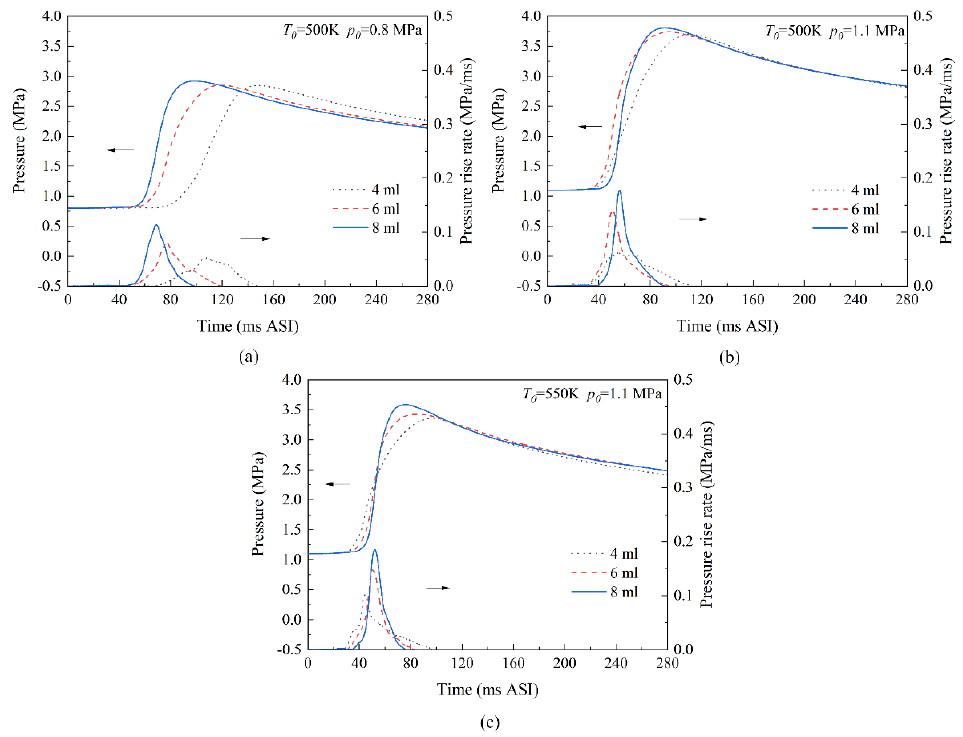
Figure 11. Jet appearance timings, ignition timings in the main chamber, and ignition delays for different pre-chamber volumes under different initial thermodynamic parameters.